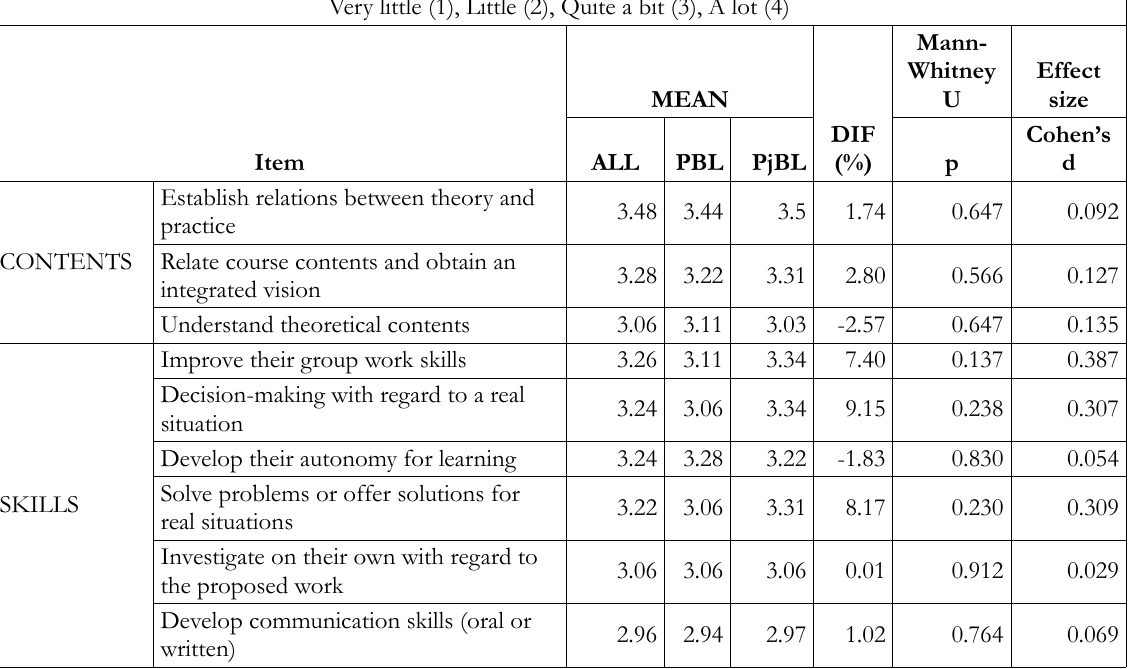
Table 2. Evaluation of the effect of PBL/PjBL on content learning and skill